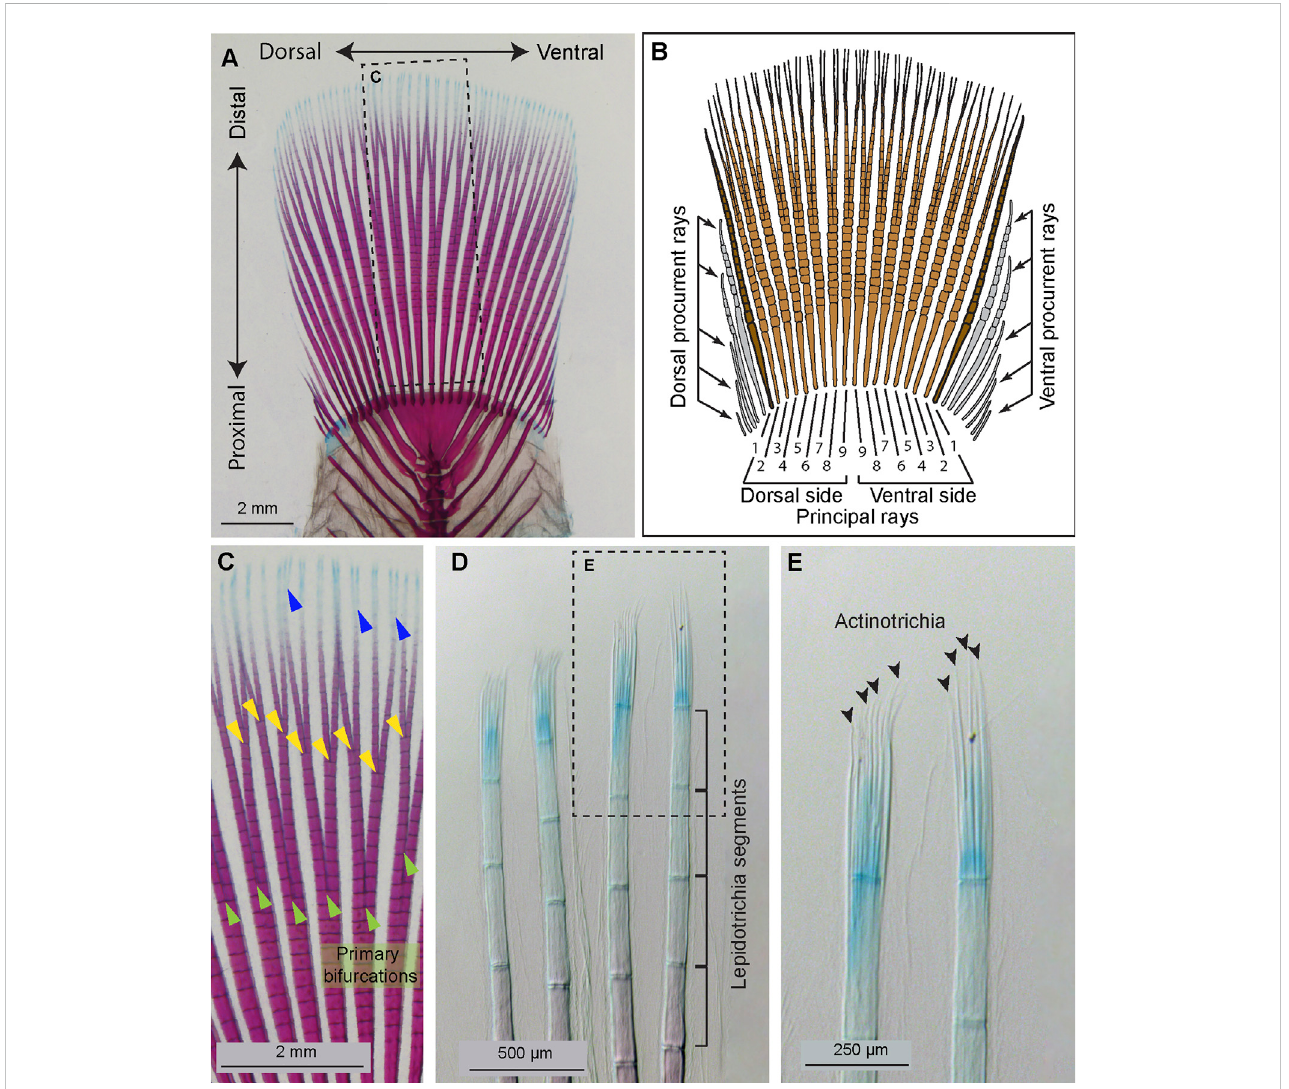
FIGURE 1 Anatomy of the platy fi sh caudal fi n. (A and C – E) A caudal skeleton of adult platy fi sh, stained with alcian blue and alizarin red to detect cartilage and mineralizedbone, respectively. (B) A schematic oftheplaty fi sh caudal fi nillustrates acompoundorganization oftheappendage.The distalmarginofthe fi nis supported by typically 18 principal rays, among which 16 are branched (light brown) and two unbranched (dark brown). The base of the fi n is widened by procurrent rays (grey) that are short and unbranched. (C) A magni fi cation of the framed area in (A) , with indicated ray branchpoints: primary (green arrowheads), secondary (yellow arrowheads), and occasional tertiary (blue arrowheads) ray bifurcations. (D) The distal tip of rays comprises non-calci fi ed lepidotrichialeadingtoagradientofalizarinredandalcianbluestainingalongtheproximal-distalaxis.Segmentationoftheraysisvisibleatthismagni fi cation. (E) A higher magni fi cation of the framed area in (D) allows visualization of unstained actinotrichia fi laments (black arrowheads) through contrast imaging. Actinotrichia are located at the level of the distal-most segment of the rays.